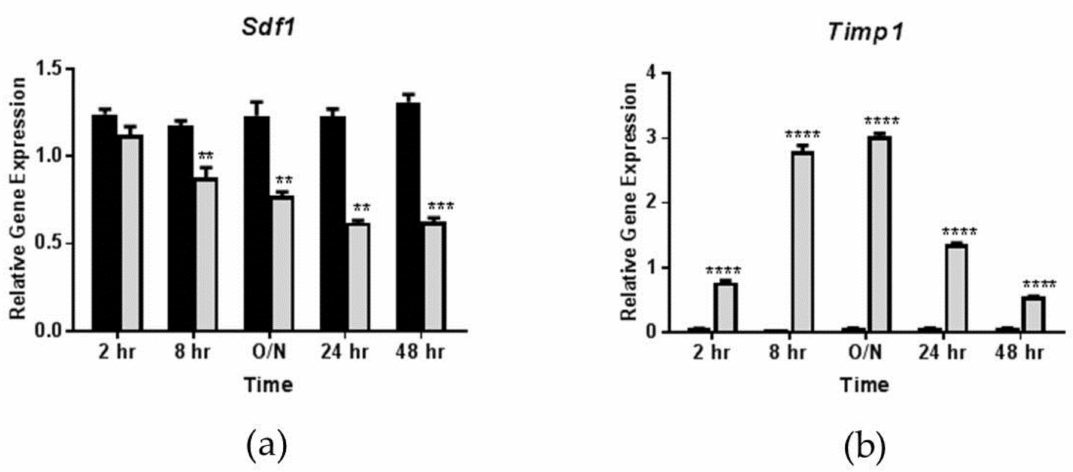
Figure 2. Oncostatin M (OSM) suppresses adipocyte Sdf1 expression in a time-dependent manner. Fully differentiated 3T3-L1 adipocytes were exposed to 0.5 nM OSM for 2 h, 8 h, ~12 h (overnight; O/N), 24 h, or 48 h. Gene expression was then analyzed and expression levels were normalized to a numerical average of three housekeeping genes ( Ppia , Ubb , and Nono ). ( a ) Effects of 0.5 nM OSM on Sdf1 expression in 3T3-L1 adipocytes; ( b ) Effects of OSM on Timp1 expression in 3T3-L1 adipocytes (shown as a positive control). Black bars = vehicle-treated cells; gray bars = OSM-treated cells. ** p < 0.01, *** p < 0.001, and **** p < 0.0001 vs. vehicle control. This experiment was performed